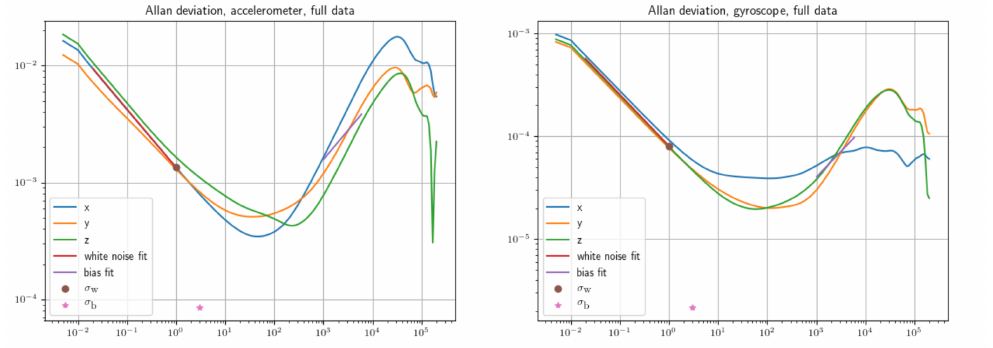
Figure 7. Example of modeling accelerometer and gyroscope bias by cubic B-spline.